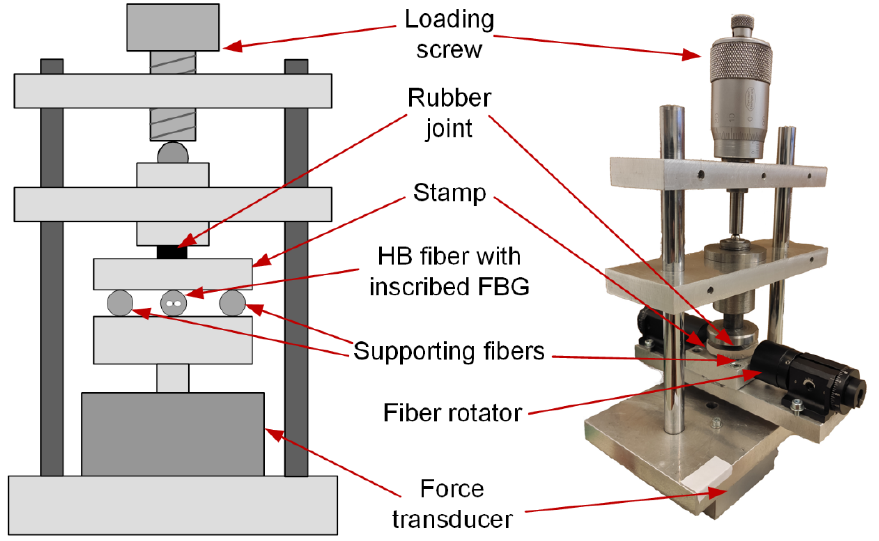
Figure 5. Scheme of a testing rig for the HiBi FBG